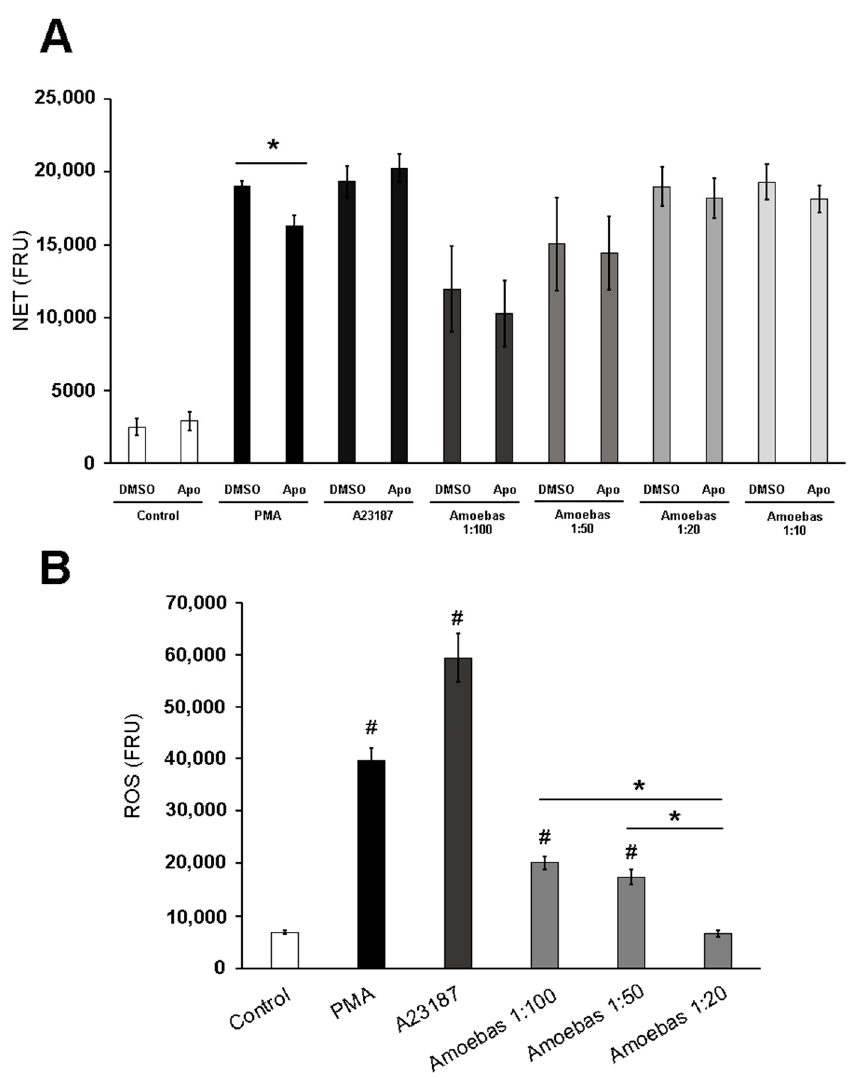
Figure 2. NETosis induced by E. histolytica occurs independently of NADPH oxidase. ( A ) Neutrophils (1 × 10 5 ) were pretreated with 400 µM apocynin (Apo) or DMSO for 30 min. Posteriorly, cells were transferred to RPMI-1640 medium added with 5% FBS and 500 nM SYTOX ® Green and then stimulated with PMA (50 nM), A23187 (10 µM) or E. histolytica trophozoites at ratios of 1:100, 1:50, 1:20 and 1:10. Fluorescence was read at 4 h. ( B ) H 2 DCFDA-pretreated neutrophils (1 × 10 5 ) were culture in RPMI-1640 medium supplemented with 5% FBS and then stimulated with PMA (50 nM), A23187 (10 µM) or E. histolytica trophozoites at ratios 1:100, 1:50 or 1:20. Fluorescence was read at 1 h. NET and ROS amounts are expressed in fluorescence relative units (FRU). Values are means ± SD of three independent experiments. * p < 0.0001, # p < 0.001 with respect to control.